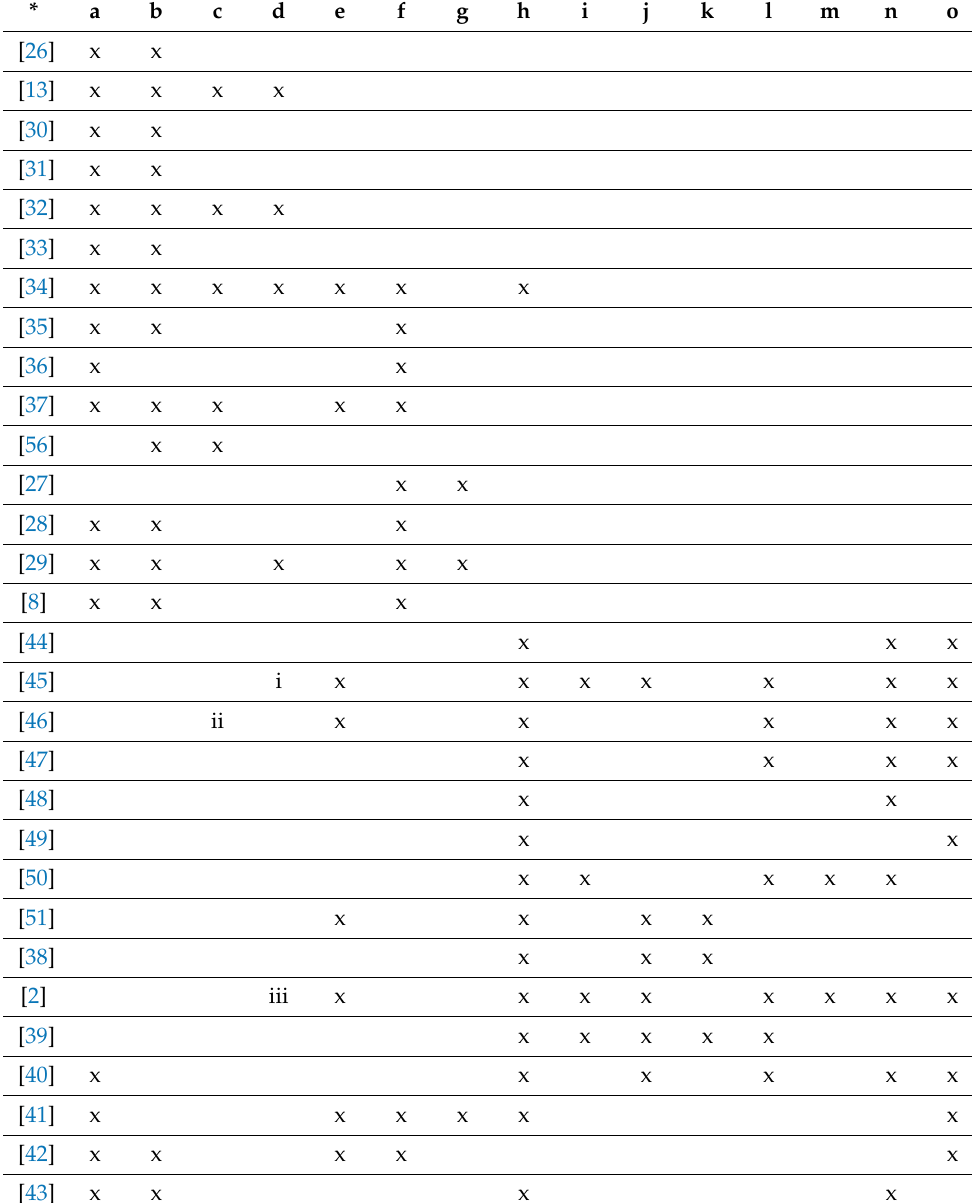
Table 1. Comparative table of reviewed related